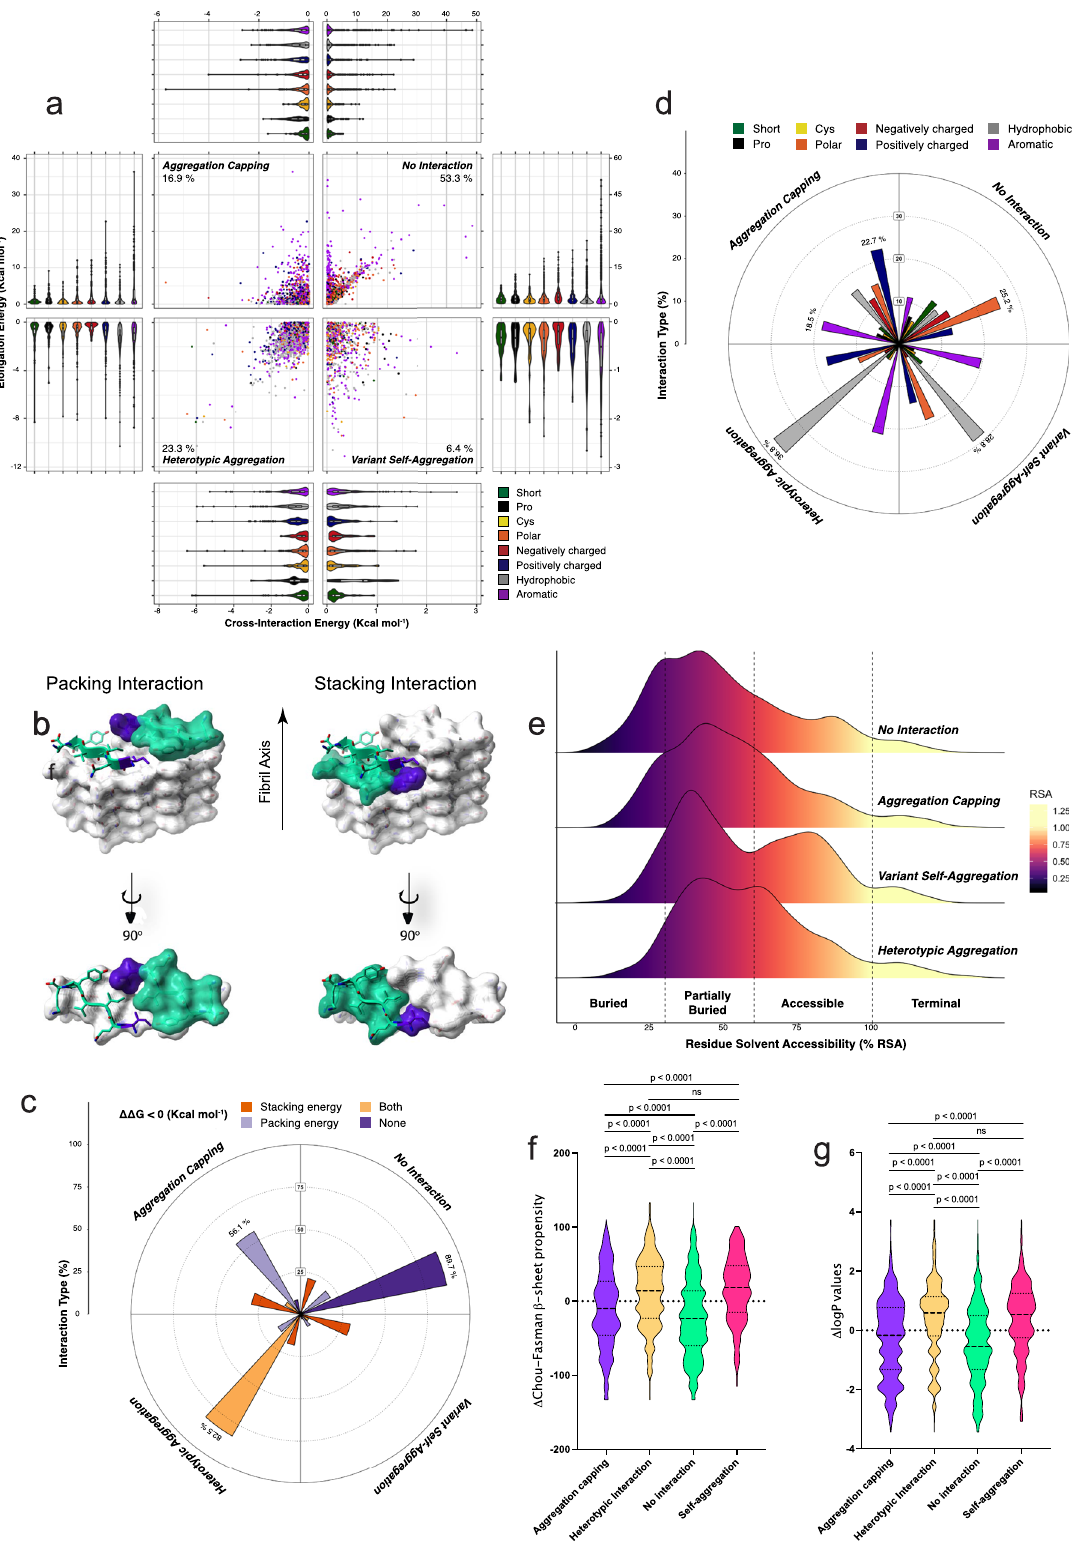
engineered antiviral and antibacterial peptide designs 78,79 , which also indicated that two mismatches are suf fi cient to inhibit cross- seeding. We identi fi ed a linear correlation between cross-interaction and elongation free energy potentials for the majority of sequence variants ranging from heterotypic aggregation to non-interactors evident when comparing cross-sectional packing